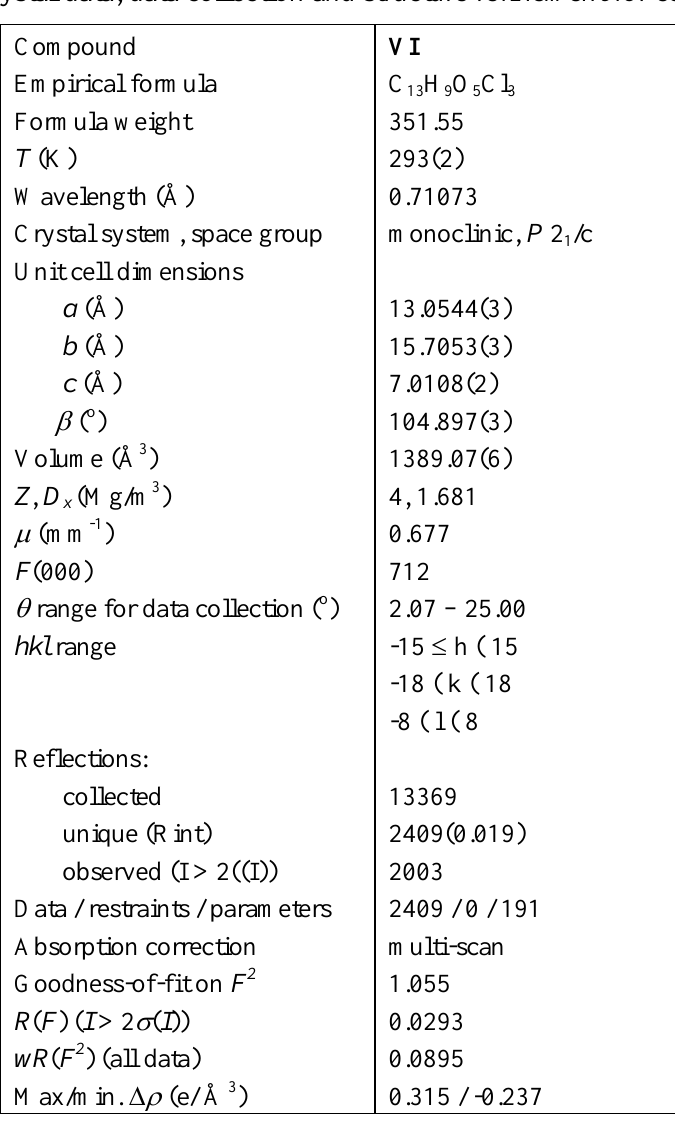
Table 4. Crystal data, data collection and structure refinement for compound VI